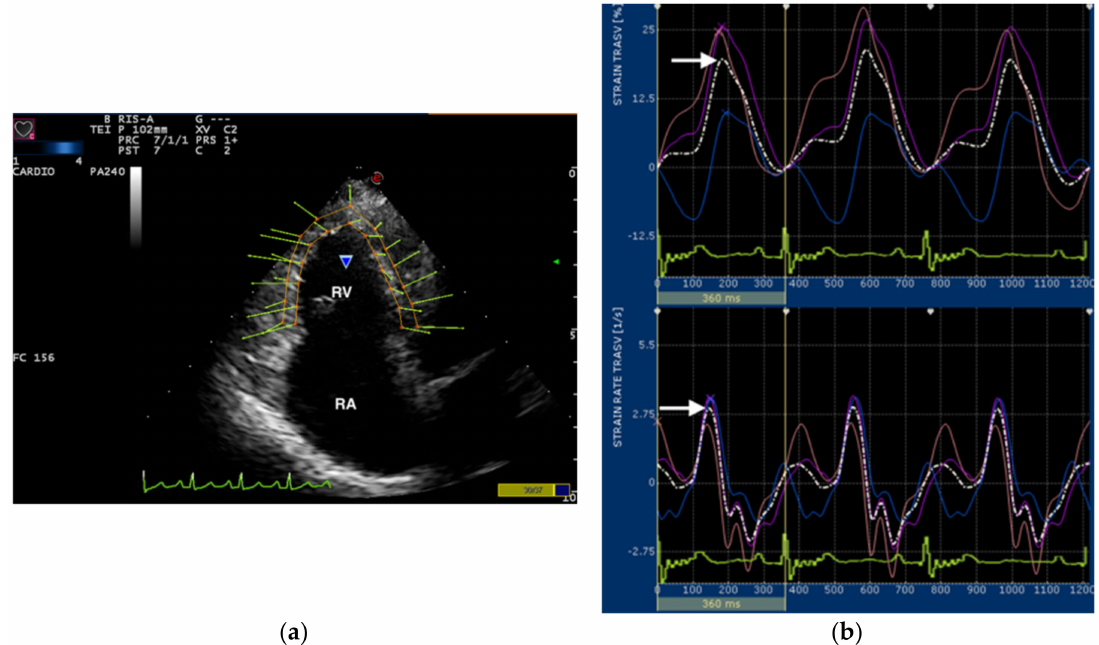
Figure 1. ( a ) Snapshot of 2-dimensional speckle tracking analysis from left apical 4-chamber view optimized for visualization of the right ventricle (RV). Thirteen points delimit and follow the endocardial and epicardial border of the RV frame by frame during entire cardiac cycle. The green arrows represent the vectors of each point and their direction of displacement. RV, right ventricle; RA, right atrium; ( b ) Snapshot of transverse strain (upper) and strain rate (lower) curves of the RV free wall. The software divided the entire RV into 6 segments, each containing 3 points (1 or 2 points were shared between adjacent segments). Tree segments corresponding to the interventricular septum were excluded and only three segments of RV free wall (colored line) were used for measurements. The software also generates an average value (dotted line) of the transverse RV strain and strain rate. The snapshot shows strain and strain rate curves over time in relation to the electrocardiogram (bottom). Only the systolic peak (arrows) of the transverse strain and strain rate of the RV free wall were used in this study. To assess the intra- and inter-observer measurement variability, six echocardiograms of six di ff erent dogs were randomly selected for repeated measurements by the same observer (D.C.) and by a second observer (V.P.). Intraobserver measurement variability was evaluated by having each observer trace and analyzes the same cardiac cycles on two di ff erent days. Interobserver measurement variability was evaluated by having the two observers independently trace and analyze the same cardiac